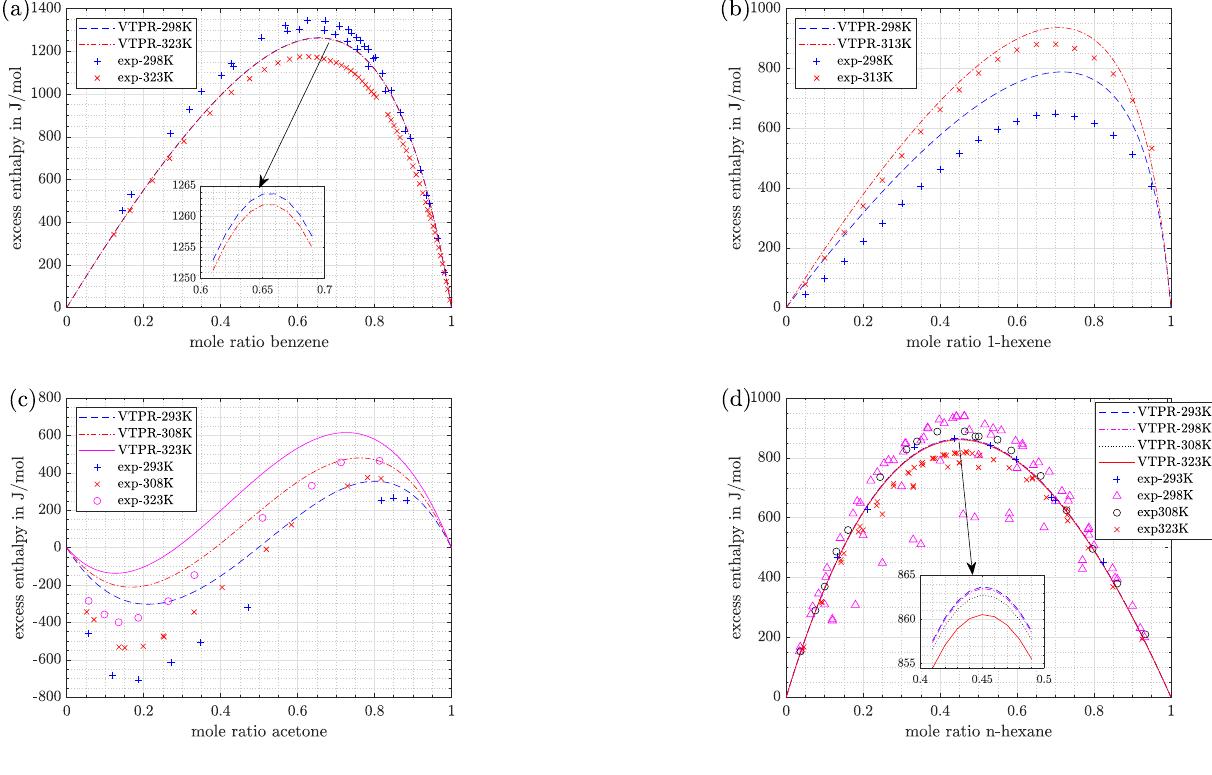
Figure 1. Experimental and predicted values of selected model systems. ( a ) n-hexadecane/benzene (T = 298.15/323.15 K); experimental data: [20–22] ( b ) 1-hexene/n-BuOH (T = 298.15/313.15 K); experimental data: [23] ( c ) acetone/water (T = 293.15/308.15/323.15 K); experimental data: [24] ( d ) n-hexane/benzene (T = 293.15/298.15/308.15/323.15 K); experi- mental data: